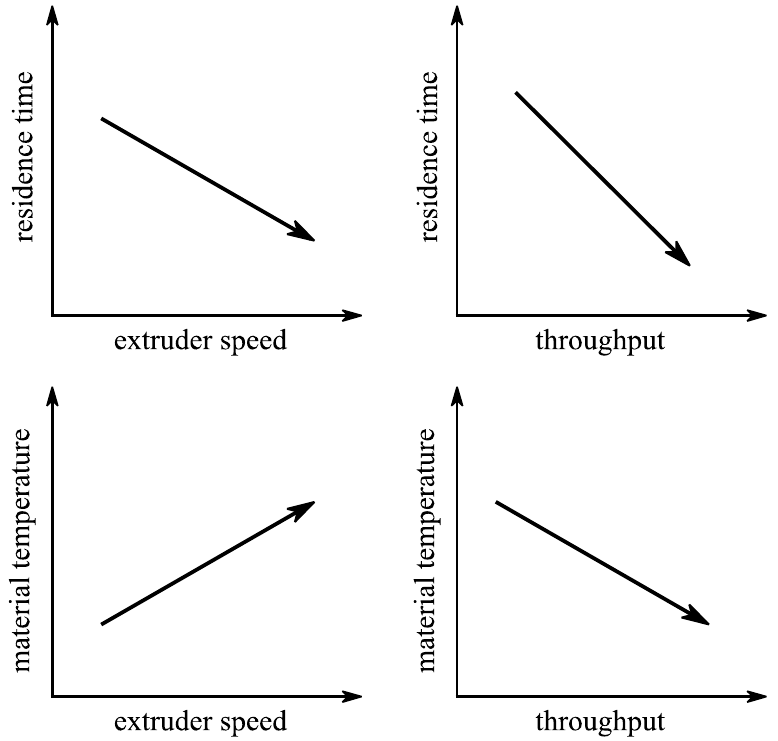
Figure 9. Qualitative influence of extruder speed and throughput on residence time and material temperature.